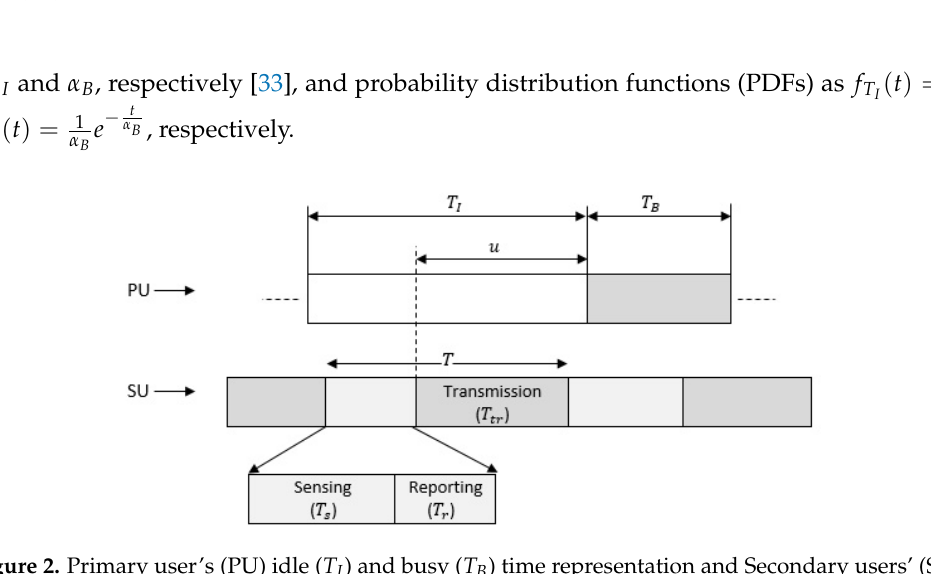
Figure 2. Primary user’s (PU) idle ( T I ) and busy ( T B ) time representation and Secondary users’ (SUs) time frame ( T )